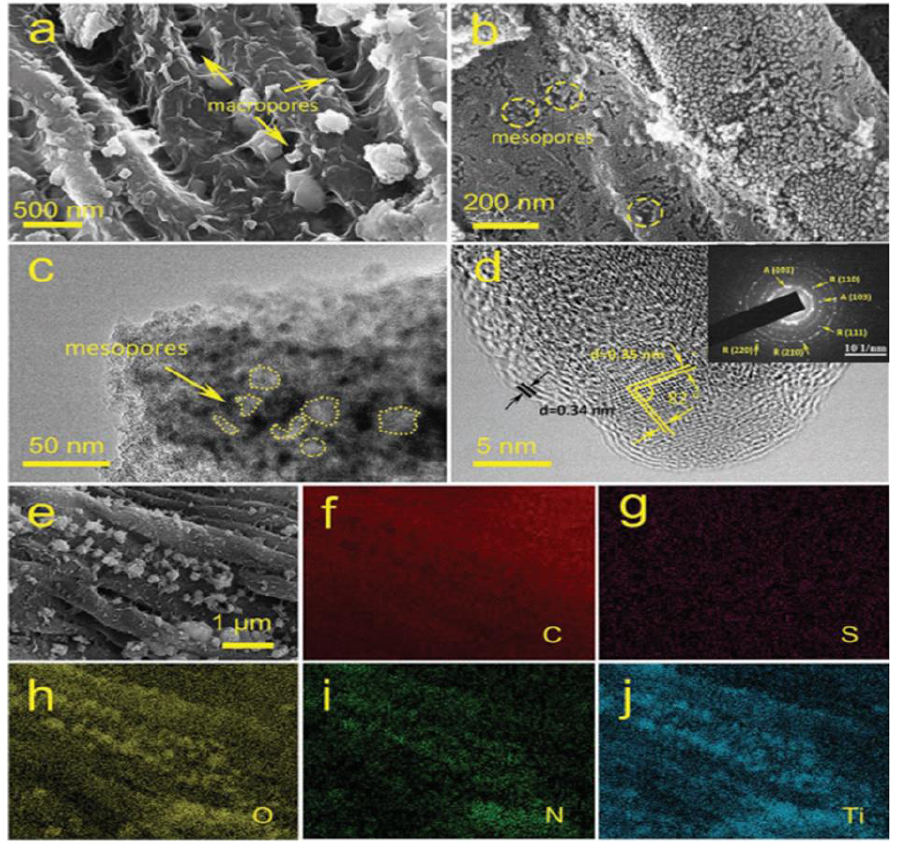
Figure 20. ( a , b ) SEM images of TF3 with 1:3 proportion of titanium oxo acetate (TOA) and plane tree fluff (PTF), with low and high magnifications; ( c , d ) bright-field and high-resolution TEM images of TF3 with the inset as the selected area electron diffraction (SAED). Anatase is noted as A and rutile as R; ( e – j ) EDX mapping of different component elements. Adapted with permission from ref. [116].